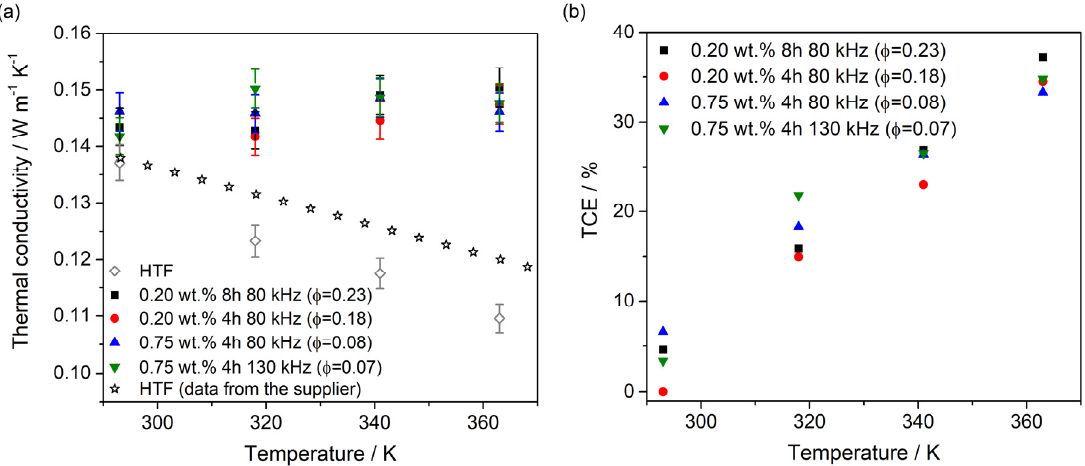
Figure 7. Thermal conductivity for nanofluids and pure HTF ( a ) and percentages of thermal conductivity enhancements for nanofluids compared to HTF ( b ). The values for pure HTF from the supplier are included for comparison purposes.